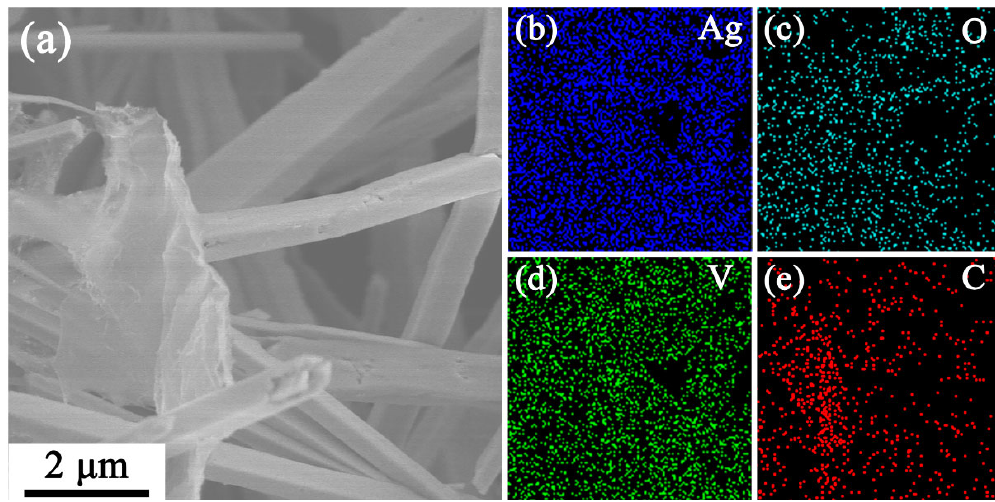
Fig. 2 SEM image of (a) 0.5 GO/ α -AgVO 3 and the corresponding EDS elemental mappings of (b) Ag, (c) O, (d) V, and (e) C. 3. 2